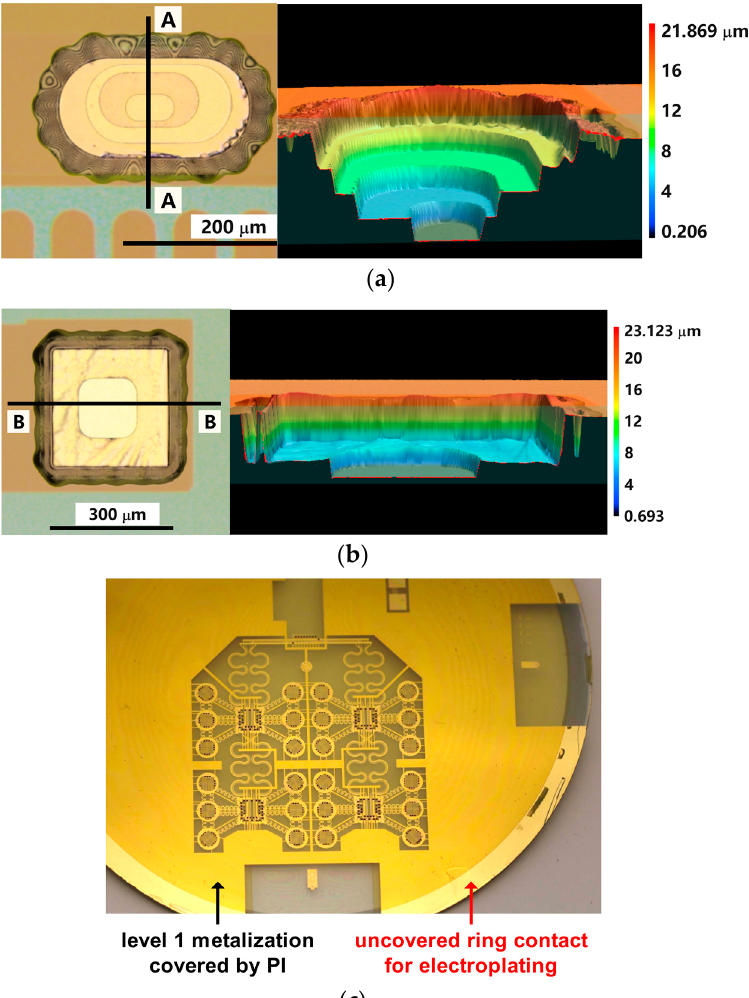
Figure 2. Schematic cross-sectional view of the via structure for connecting the individual layers.